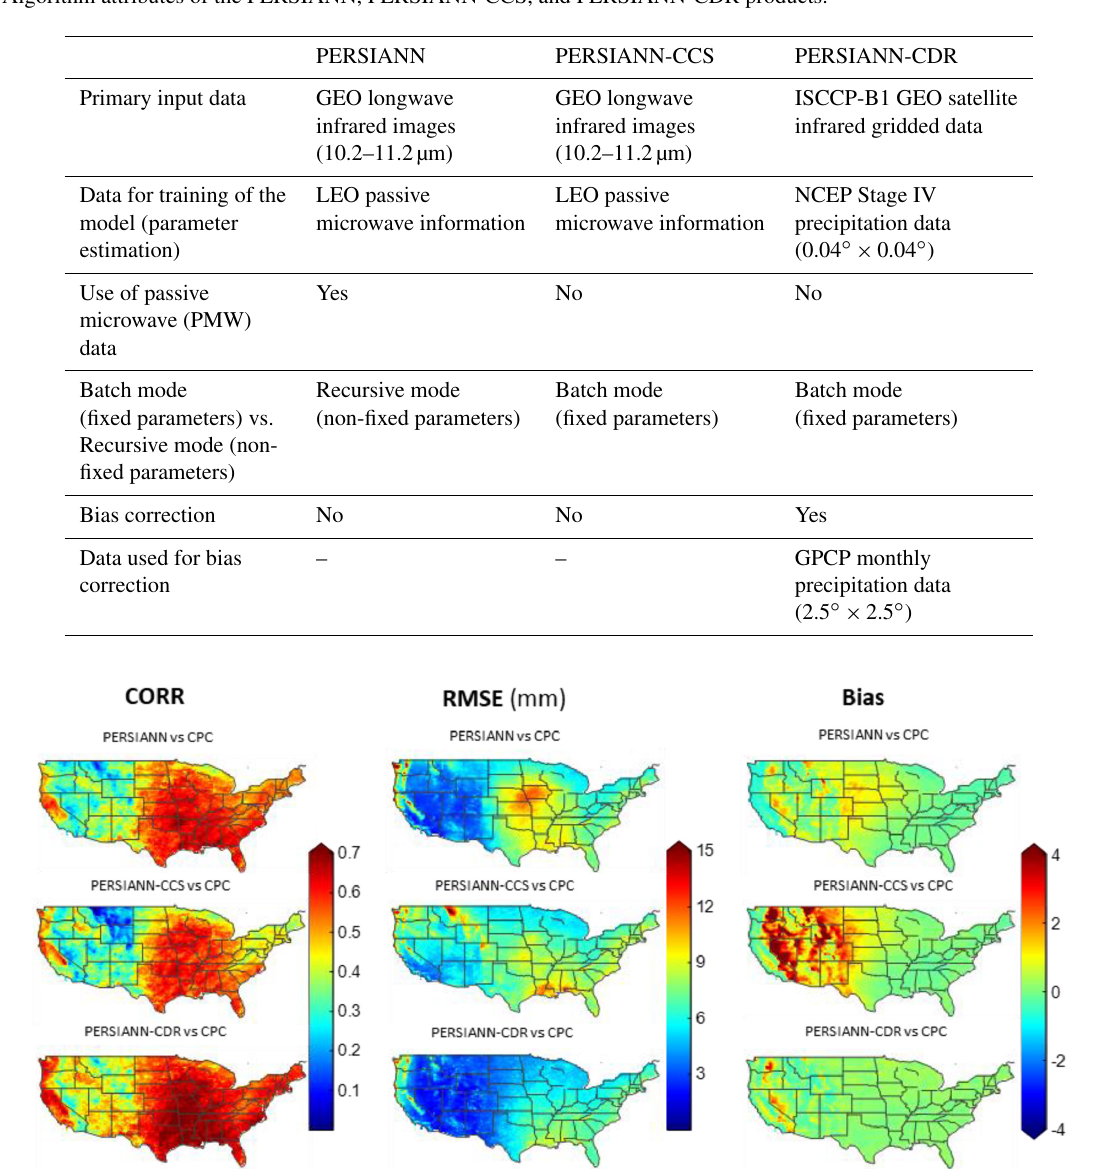
Table 2. Algorithm attributes of the PERSIANN, PERSIANN-CCS, and PERSIANN-CDR products.